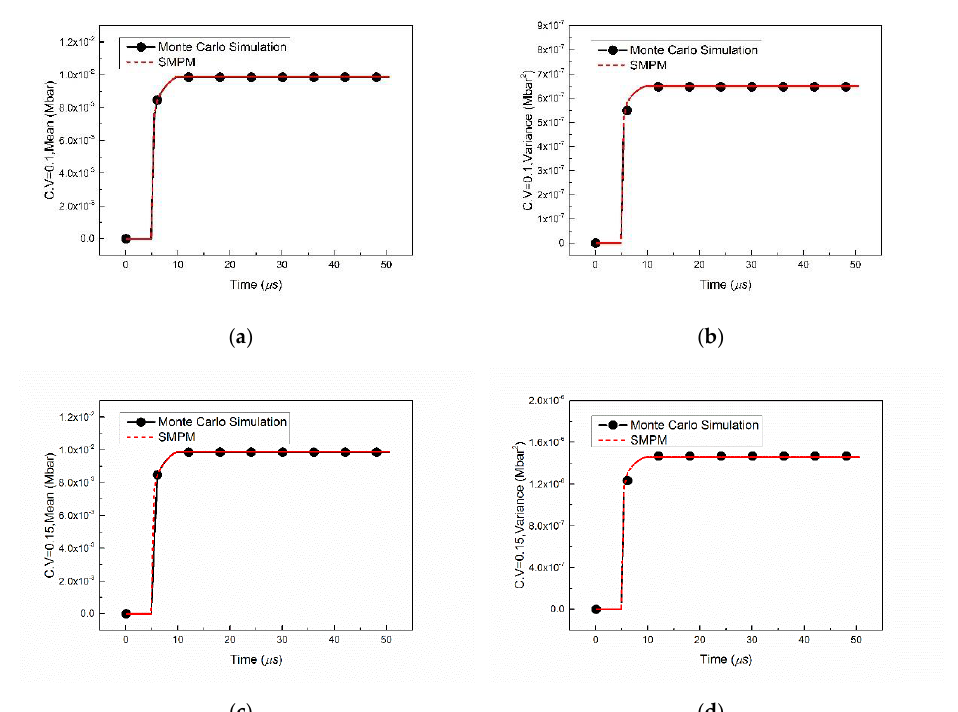
Figure 9. Equivalent plastic stress σ y response of location H by various methods with C.V=0.1 and C.V = 0.15: ( a ) Mean of σ y with C.V = 0.1; ( b ) Variance of σ y with C.V = 0.1; ( c ) Mean of σ y with C.V = 0.15; ( d ) Variance of σ y with C.V = 0.15.